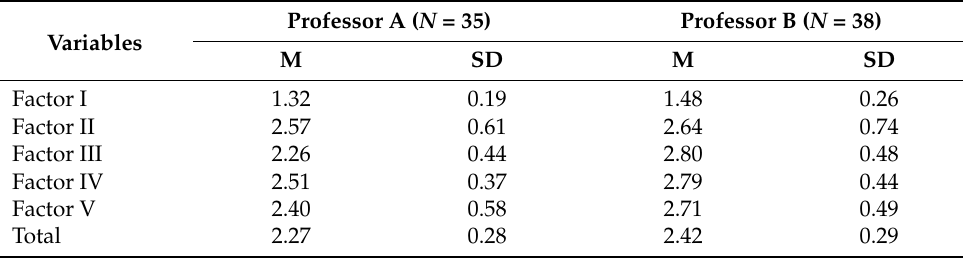
Table 5. Mean and standard deviation of perceptions of attention to diversity based on the professor.